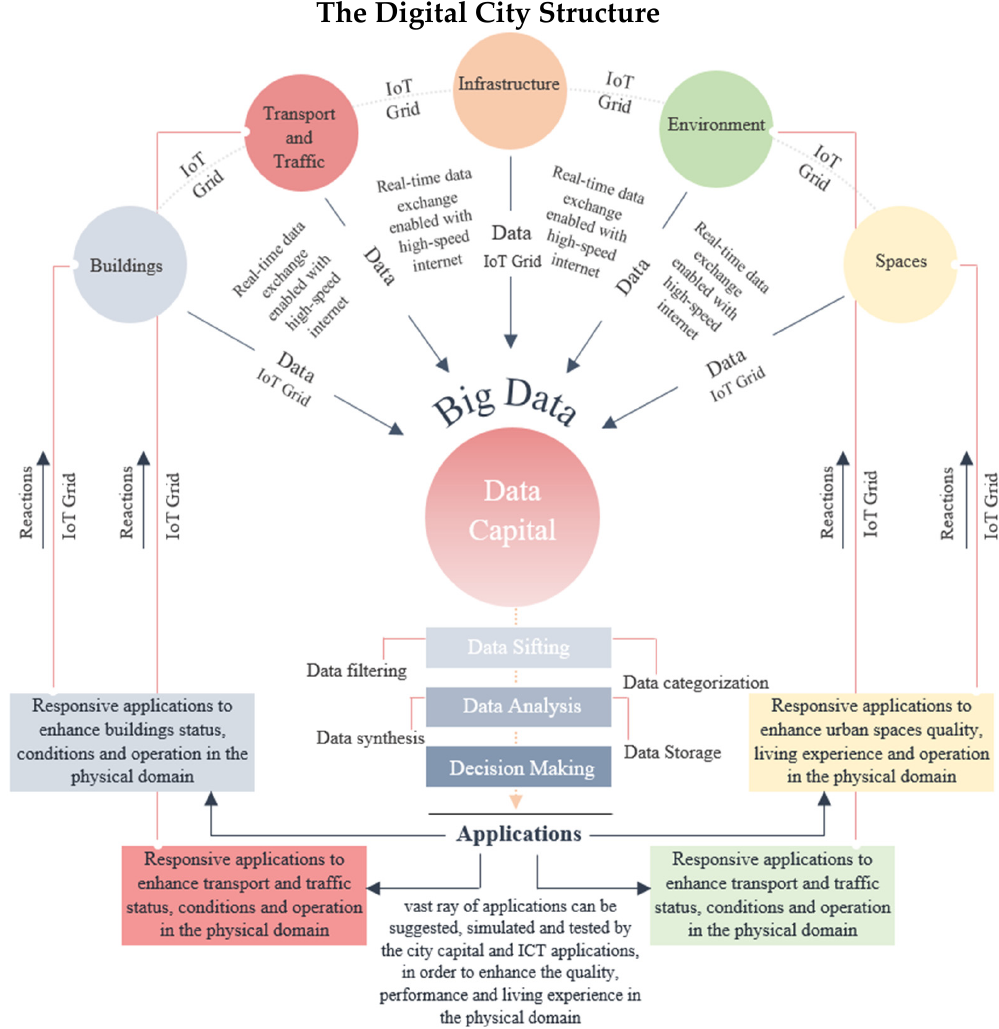
Figure 6. The conceptualization and system of digital city. Source: Authors.